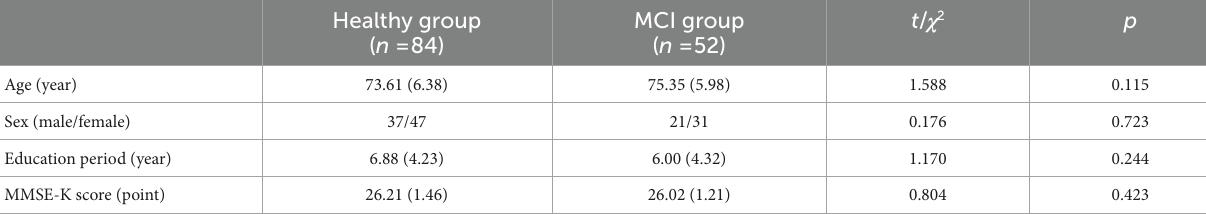
TABLE 1 General characteristic of participants ( N = 136).